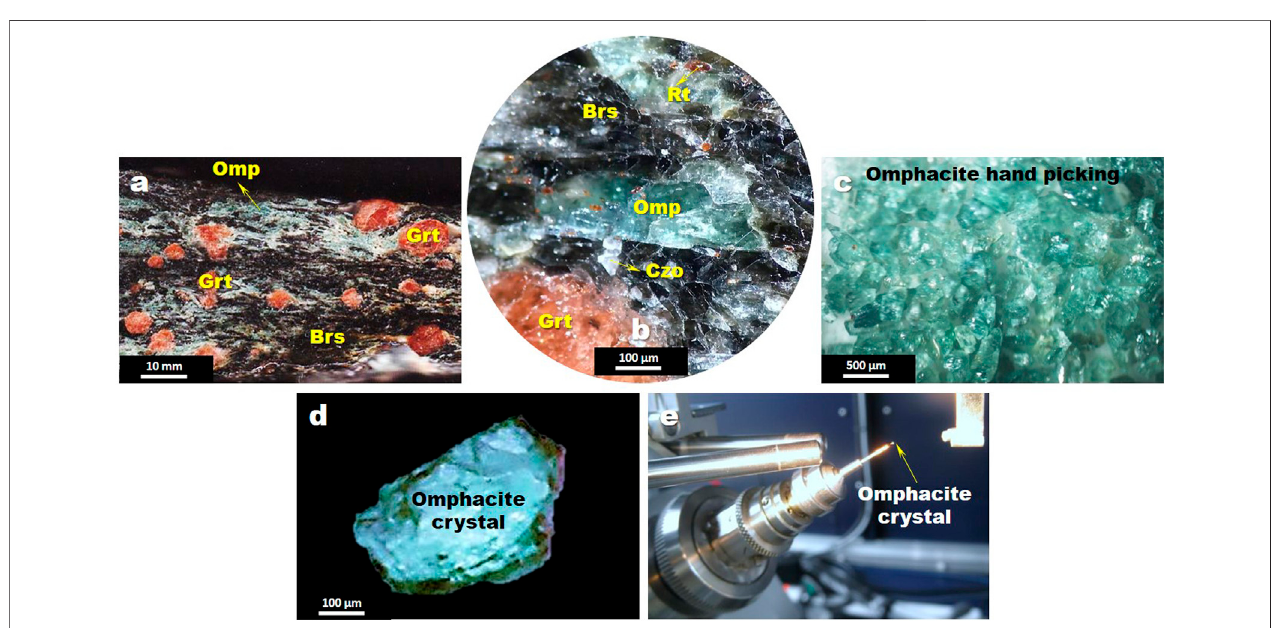
FIGURE 1 | (A,B) Macroscopic features of the analyzed omphacite-bearing eclogite showing the presence of omphacite (Omp), garnet (Grt), barroisite (Brs), clinozoisite(Czo),quartz(Qz),rutile(Rt). (C) Hand-pickedomphacitecrystalsisolatedfromtheeclogite. (D) Selectedcrystalfragmentofomphaciteusedforsinglecrystal data collection. (E) Omphacite crystal mounted on the